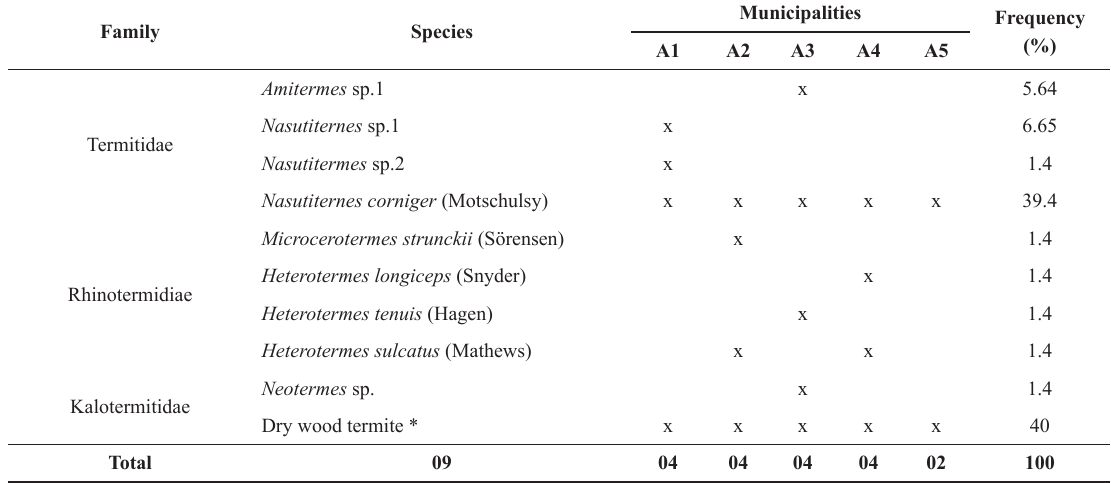
Table 1 - Frequency the termite’s species in historical and residential buildings in the municipalities of Fagundes (A1), Pocinhos (A2), Alagoa Grande (A3), Areia (A4) and Bananeiras (A5), located in the semiarid region of Brazil.